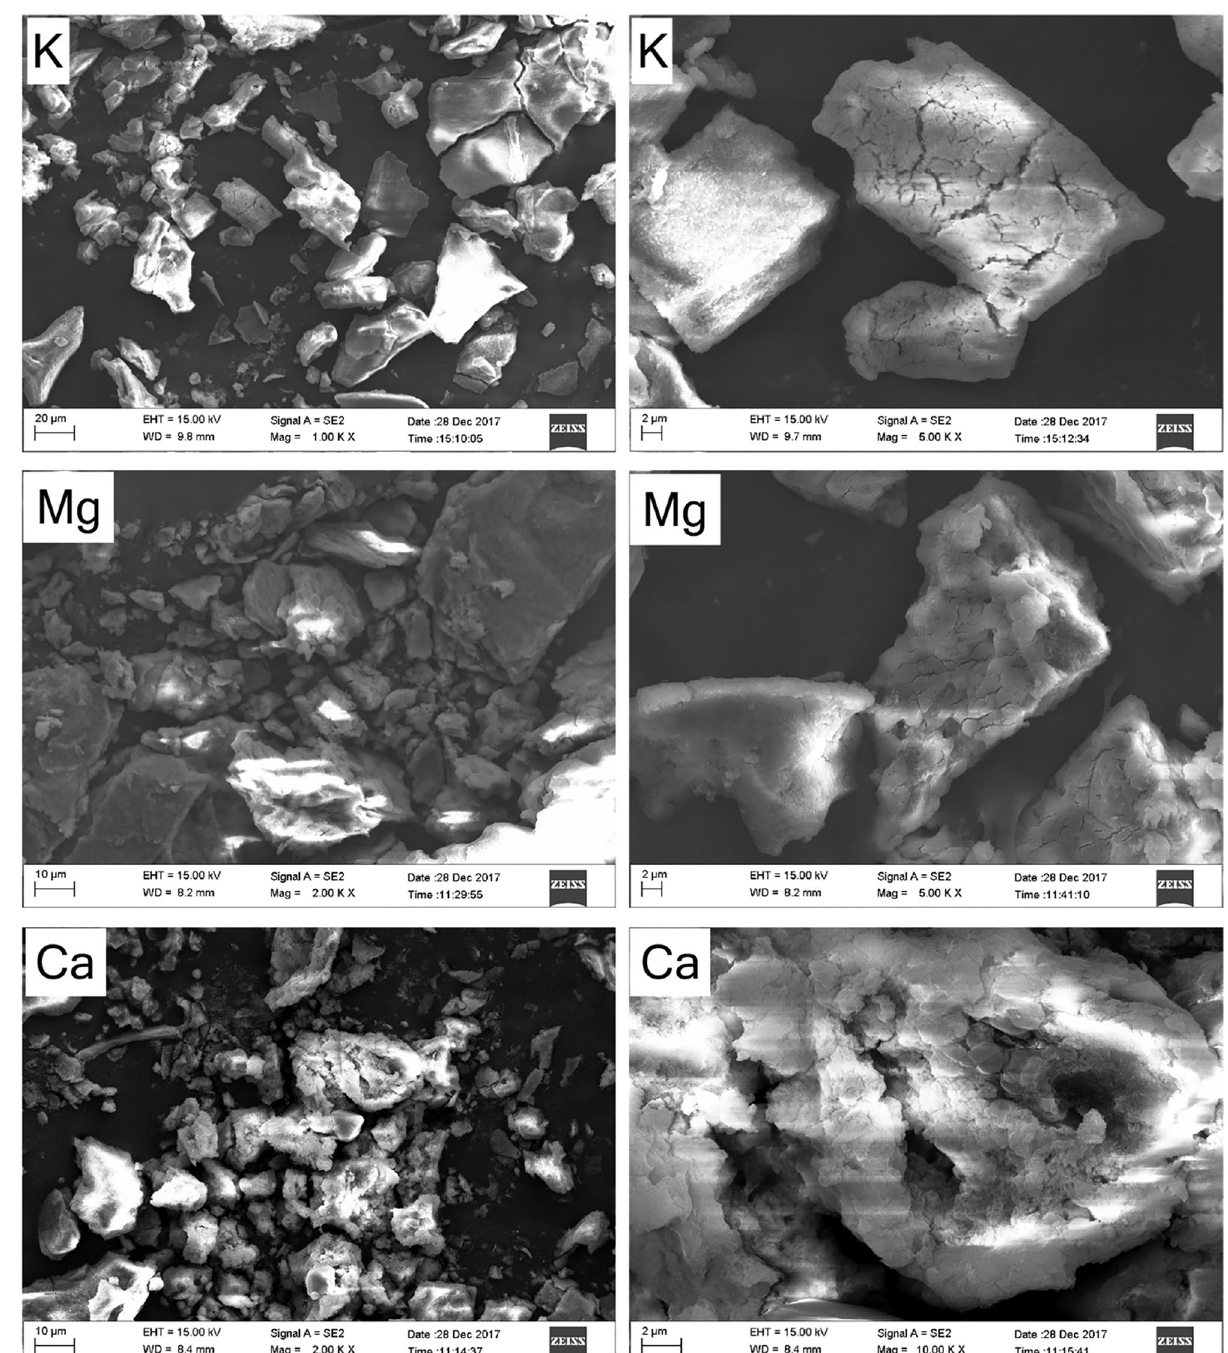
Figure 4. FESEM images of BSC aggregates with K + , Mg 2+ and Ca 2+